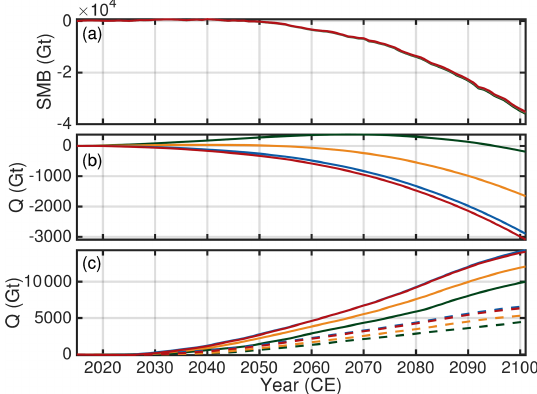
Figure 10. Time series of cumulative SMB anomaly and cumu- lative ice discharge Q . Colour scheme is as in previous figures. (a) Cumulative SMB anomaly for RCP8.5-Rnone. (b) Cumulative ice discharge Q for RCP8.5-Rnone. (c) Ice discharge for RCP8.5- Rhigh (solid lines) and RCP8.5-Rlow (dashed lines). Cumulative SMB anomaly for RCP8.5-Rhigh and RCP8.5-Rlow is qualitatively similar to RCP8.5-Rnone. Ice discharge is not corrected with the ctrl